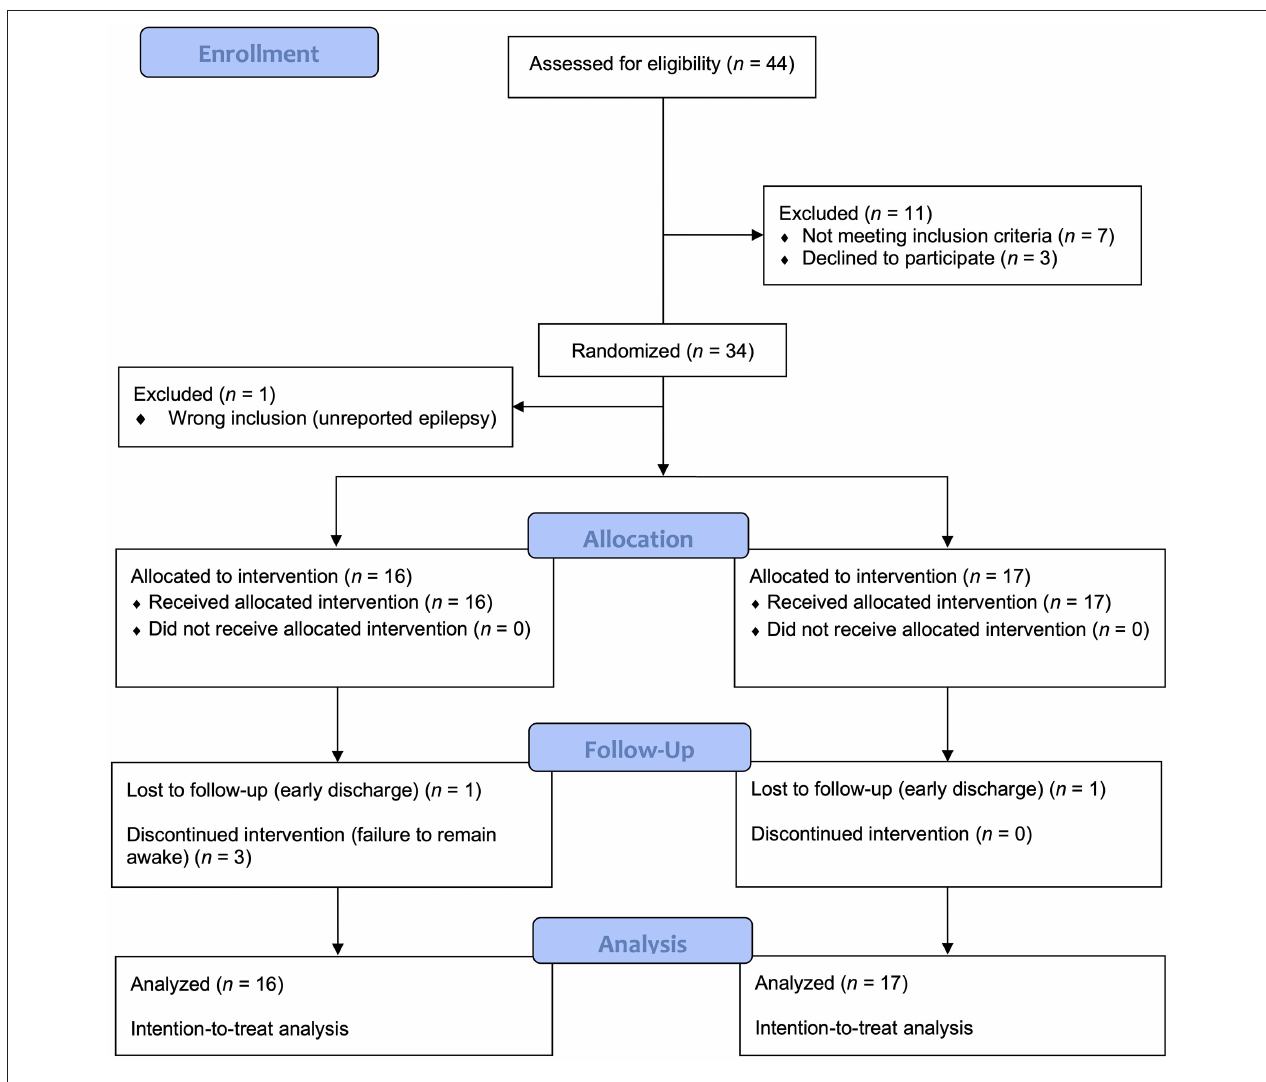
FIGURE 1 | Patient recruitment and